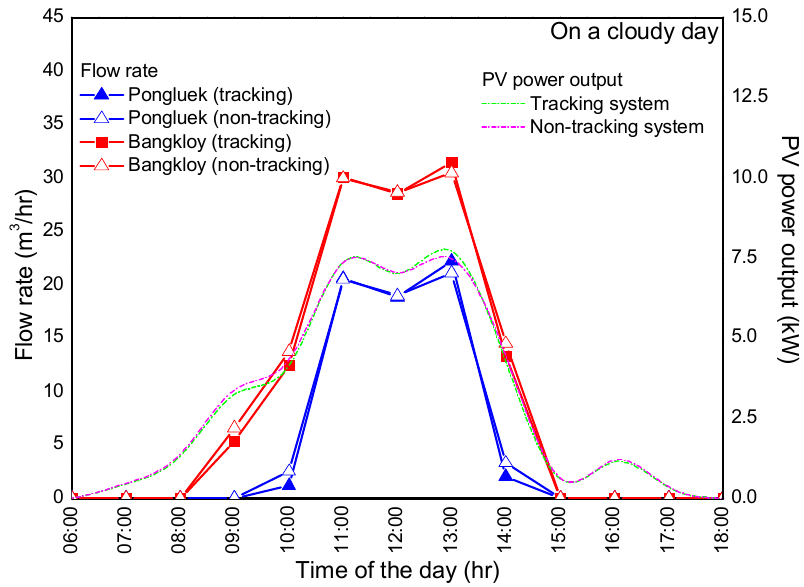
Figure 17. Pump e ffi ciency at Pongluek and Bangkloy according to the PV power output on a cloudy Figure 17. Pump efficiency at Pongluek and Bangkloy according to the PV power output on a cloudy day for tracking and non-tracking day for tracking and non-tracking SWSS.